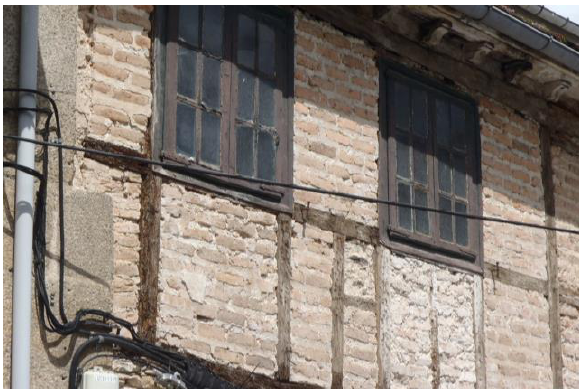
Figure 10. Detail of the half-timbered wall with brick in a house in Mondoñedo. Source: A.F.P.